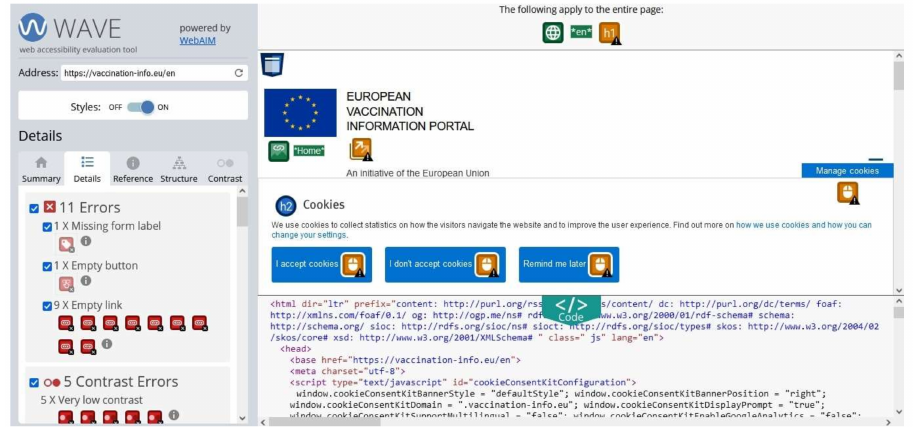
Figure 7. Screenshot of WAVE Web accessibility testing tool (view b).